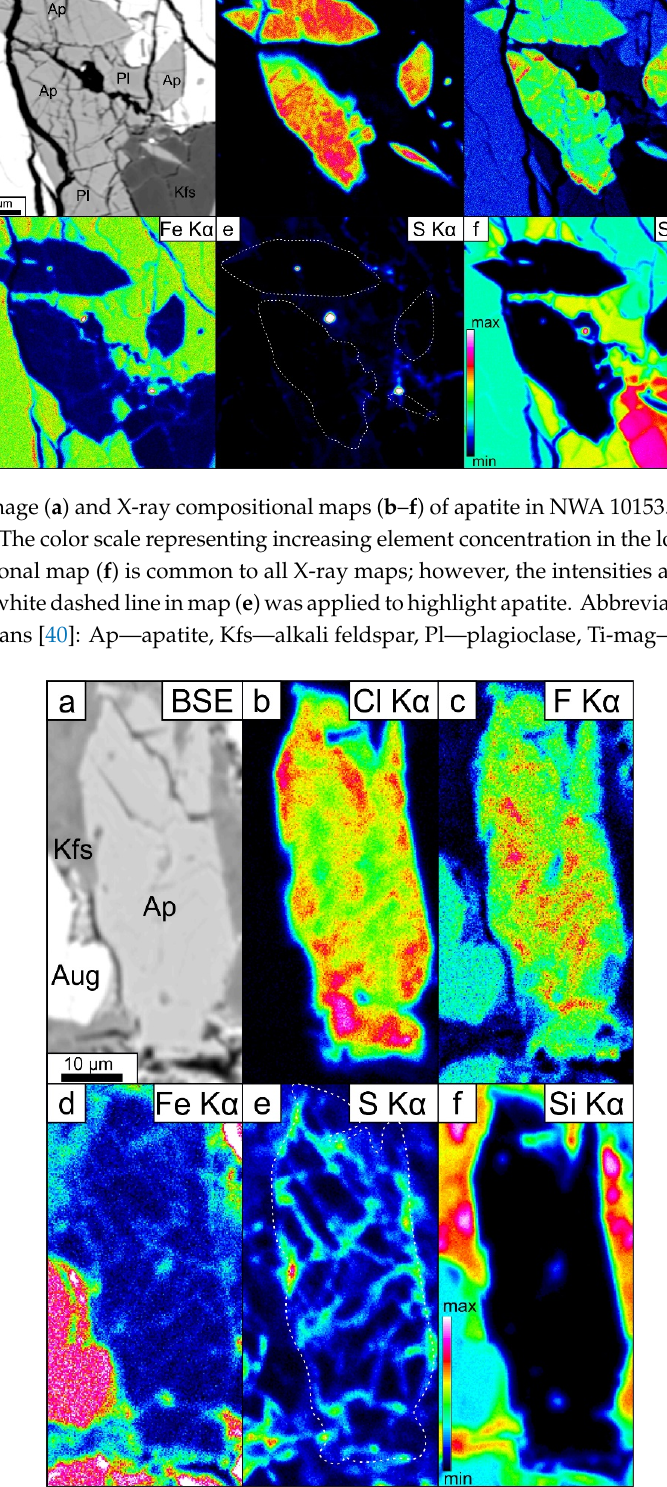
Figure 4. BSE image ( a ) and X-ray compositional maps ( b – f ) of apatite in NWA 10645. All images are at identical scales. The color scale represents increasing element concentration in the lower left corner of the X-ray compositional map ( f ), which is common to all X-ray maps; however, the intensities are not necessarily correlated. The white, dashed line in map ( e ) was applied to highlight